Question: Name the type of graph shown.
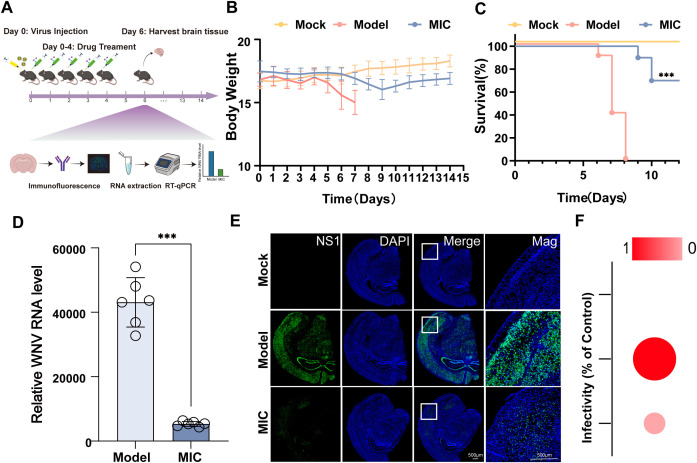
Answer: bar